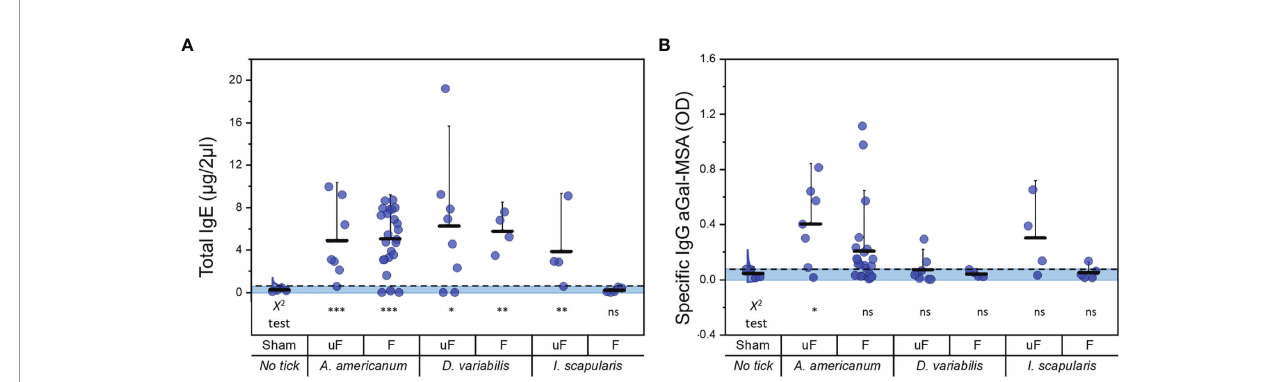
FIGURE 4 | Comparisons of total IgE and speci fi c IgG to aGal-MSA before and after feeding with different ixodid tick species. (A) total IgE (µg/2µl of serum) after tick infestation and (B) speci fi c IgG to aGal-MSA (OD in 2µl of serum) after tick feeding. uF; unfed, F; partially fed (on bovine blood before infestation into mice), Aa; A. americanum , Dv; D . variabilis , Is; I . scapularis . Kruskal-Wallis ANOVA was conducted and the lack of alphabets represents no signi fi cant differences seen with this test. Dotted lines show the cutoff for Chi square test at 0.05. Shaded areas represent the data points within the 95% distribution cutoff. The statistics below the graph represent the Chi square test (*< 0.05, **< 0.01, ***< 0.001 and ns = not signi fi cant). Error bars represent the mean (lower horizontal bar) and standard deviation (upper horizontal